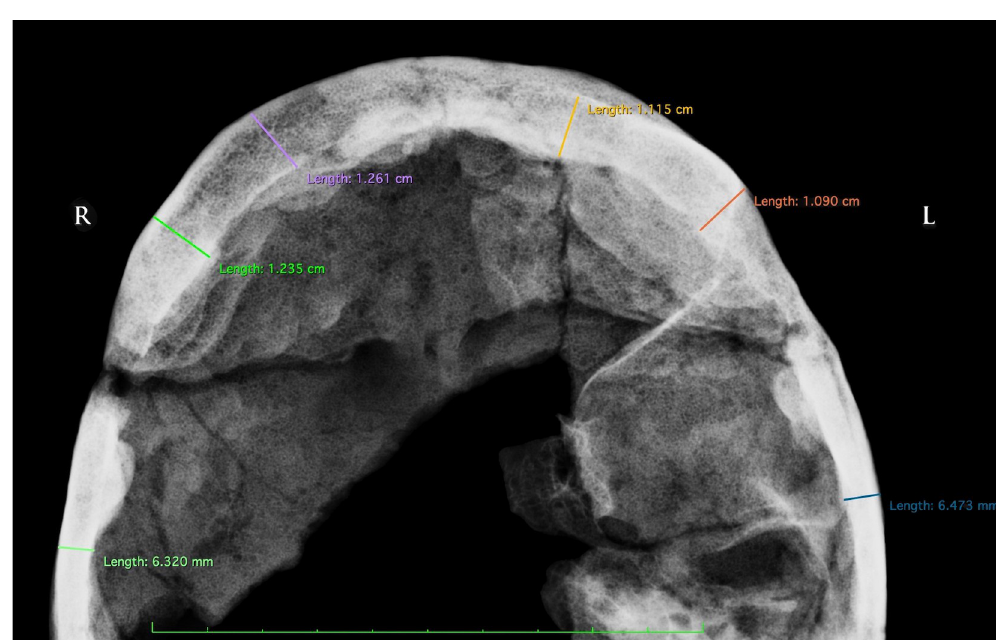
Fig 6. Postero-anterior X-ray with measurement of the thickness of the frontal and parietal bones indicating the hyperostosis. The obliteration of the frontal sinuses can be observed.